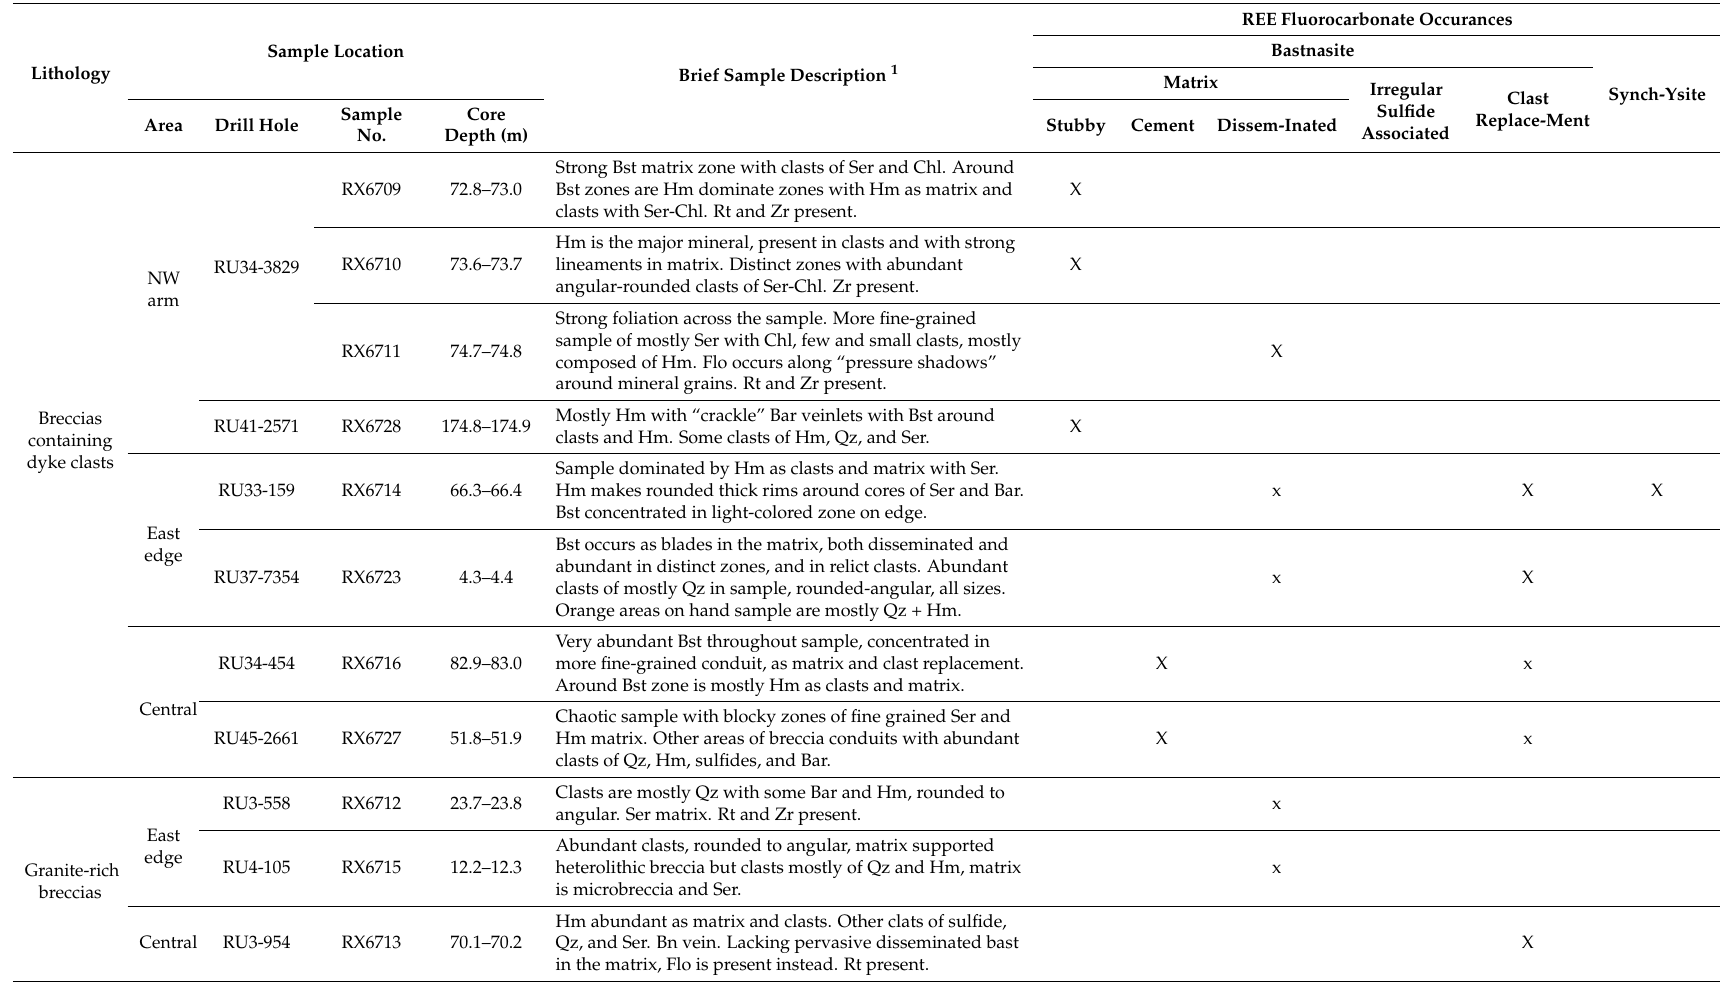
Table 1. Summary description and mineralogy of samples discussed in this